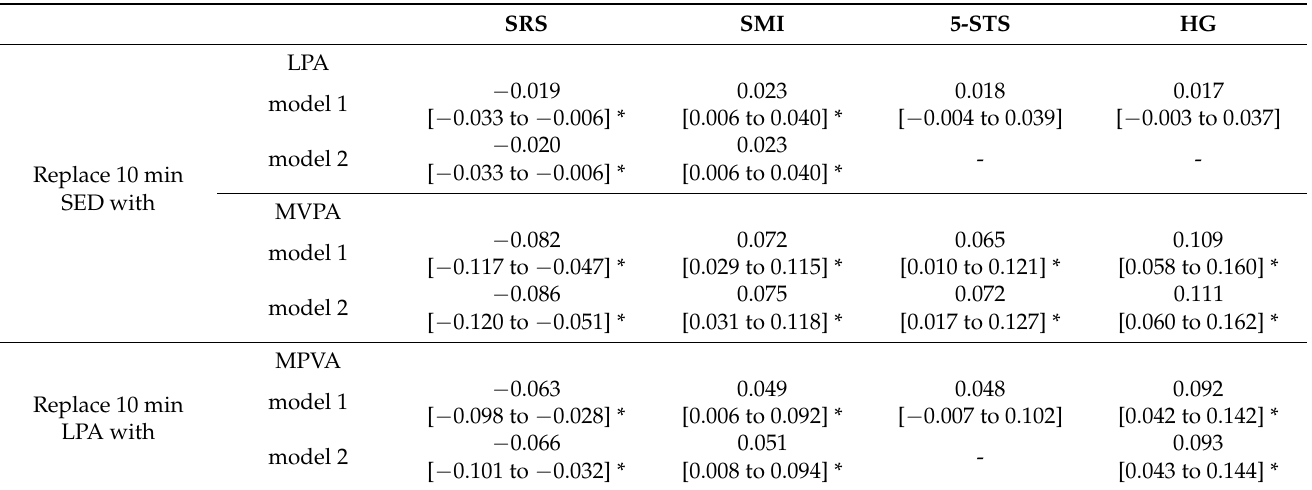
Table 3. Effect (ß-coefficient, 95% CI) of isotemporal reallocation of time spent in different PA intensities on SRS and its